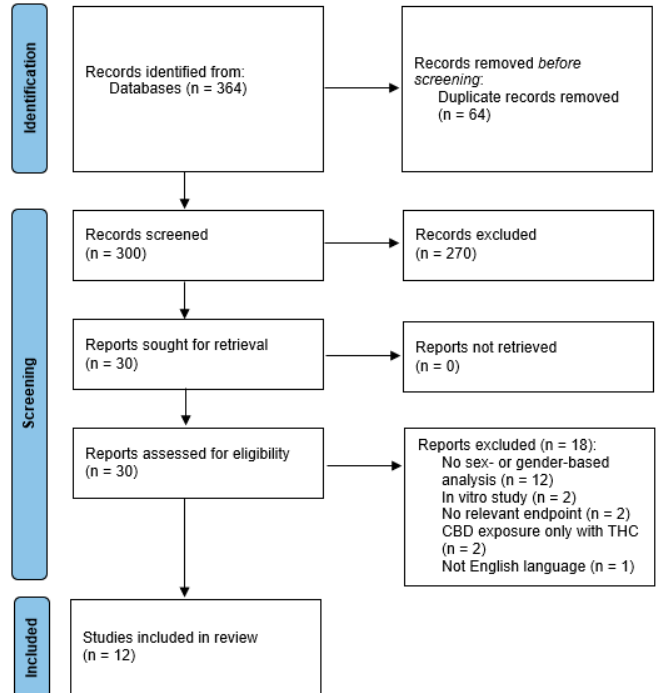
Figure 2. Flow diagram depicting article screening process, presented according to the Preferred Reporting Items for Systematic reviews and Meta-Analyses (PRISMA) [49].